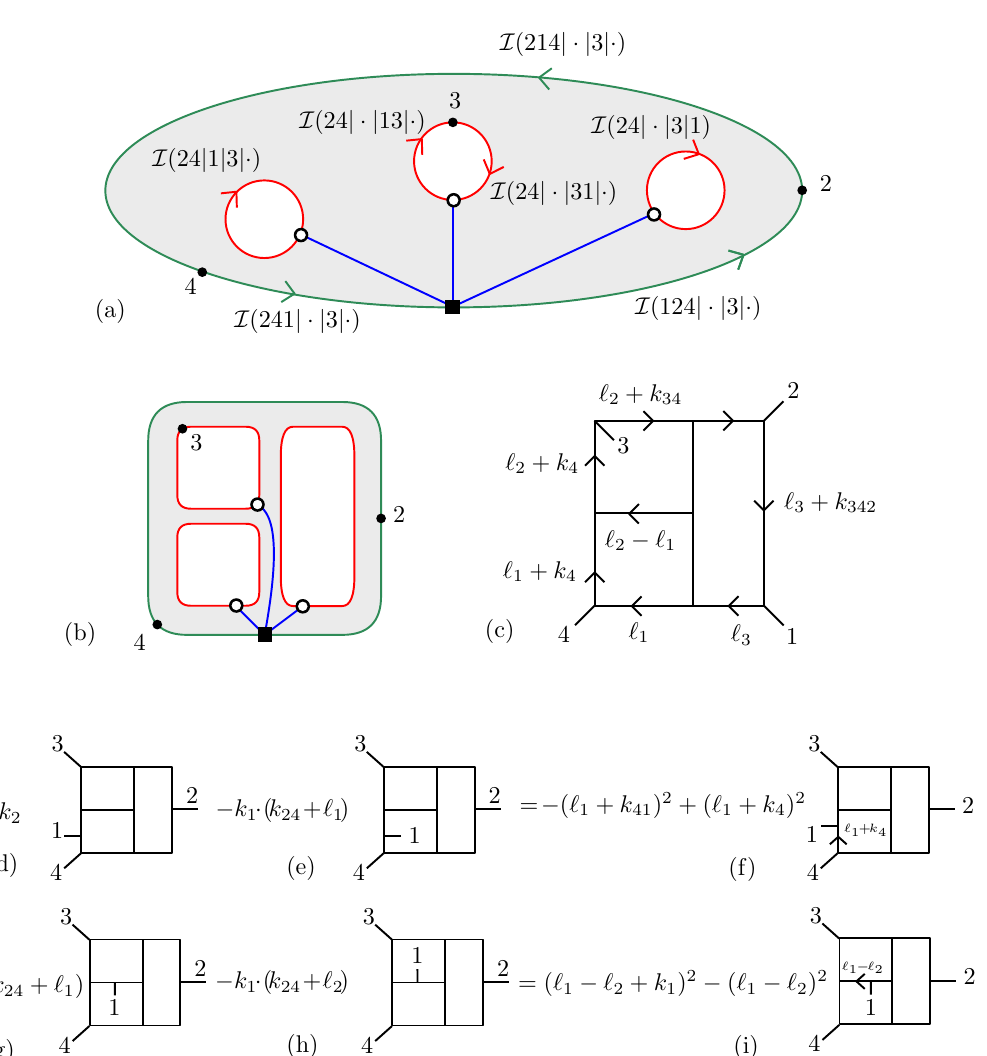
Figure 11. Proof that the accumulation of phases is a requirement for BCJ compatibility. (a) The 3-loop graph and monodromies we consider. (b) A pictorial representation of the Mercedes degeneration. The moduli space at three loops encode the other topology as well, the ladder graph, so this is only one type of degeneration that enters eq. (4.13). (c) A particular graph appearing the (cid:12)eld theory limit of I (12 j (cid:1) j 3 j(cid:1) ). Note that, because it is the amplitude from which we do the analytic continuation (it de(cid:12)nes the physical branch), this graph does not enter the (cid:12)eld theory monodromies coming from eq. (4.13) at order (cid:11) 0 (again, see details in [30, 32, 46]). (d) ! (i) Other graphs entering various terms of the monodromy relations of eq.